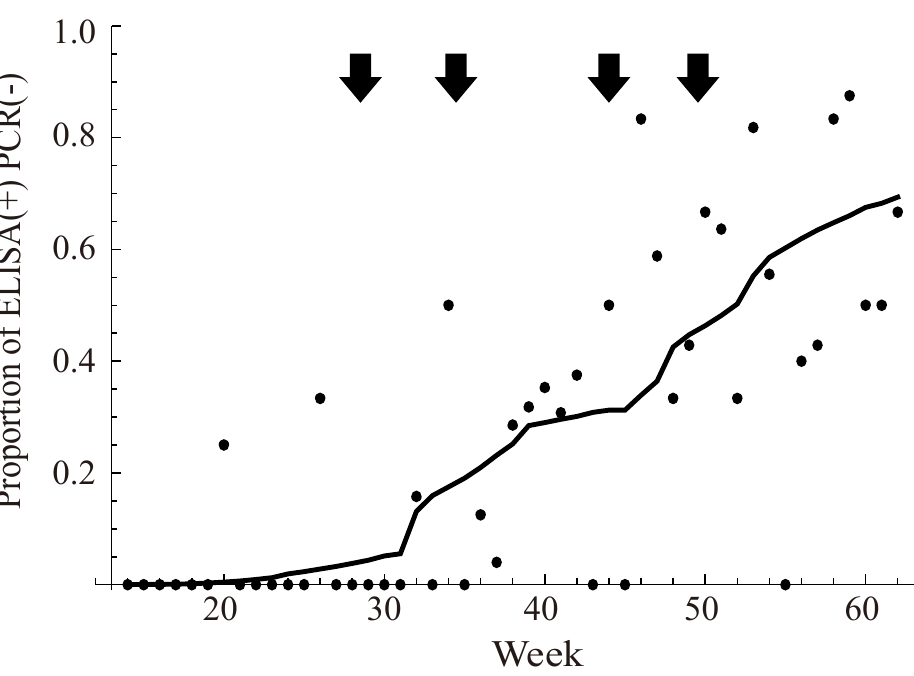
Fig 2. Model fitting with the observed proportion of ELISA(+)PCR(-) in the tested boar. We fit the model describing ( R ( t )+ V i ( t ))/ N i ( t ) by maximising the likelihood shown in Eq 18. The mean estimated proportion of ELISA i (+) PCR(-) individual is demonstrated by a solid line. Each dot denotes the observed value of the proportion of ELISA (+)PCR(-) individuals in each week. Arrows denote the vaccine